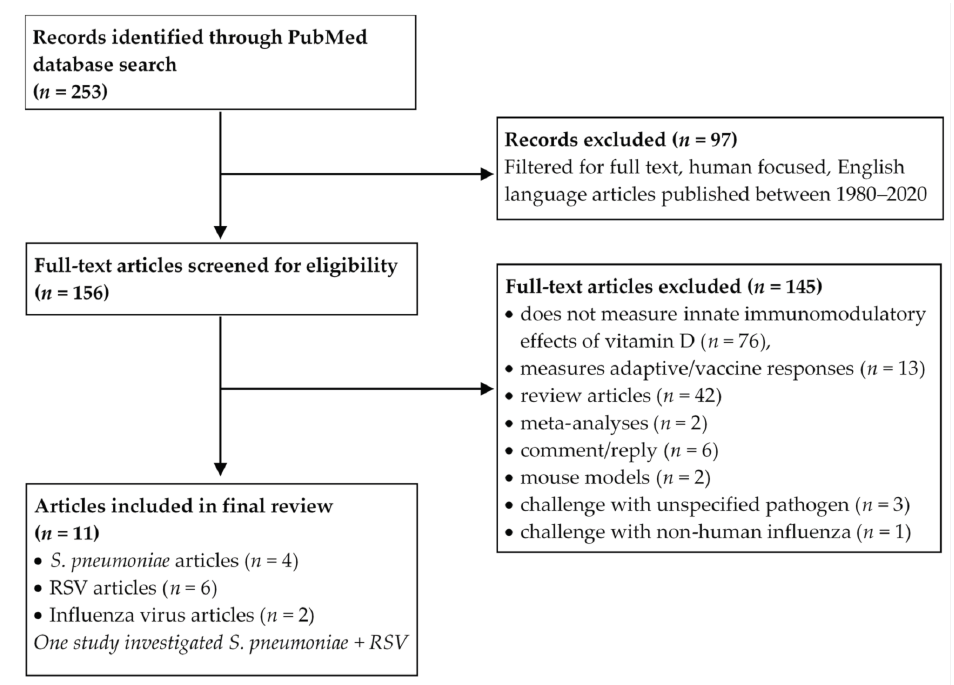
Figure 2. Preferred Reporting Items for Systematic reviews and Meta-Analyses (PRISMA) flow diagram depicting the systematic study selection process. S. pneumoniae: Streptococcus pneumoniae, RSV: Respiratory Syncytial